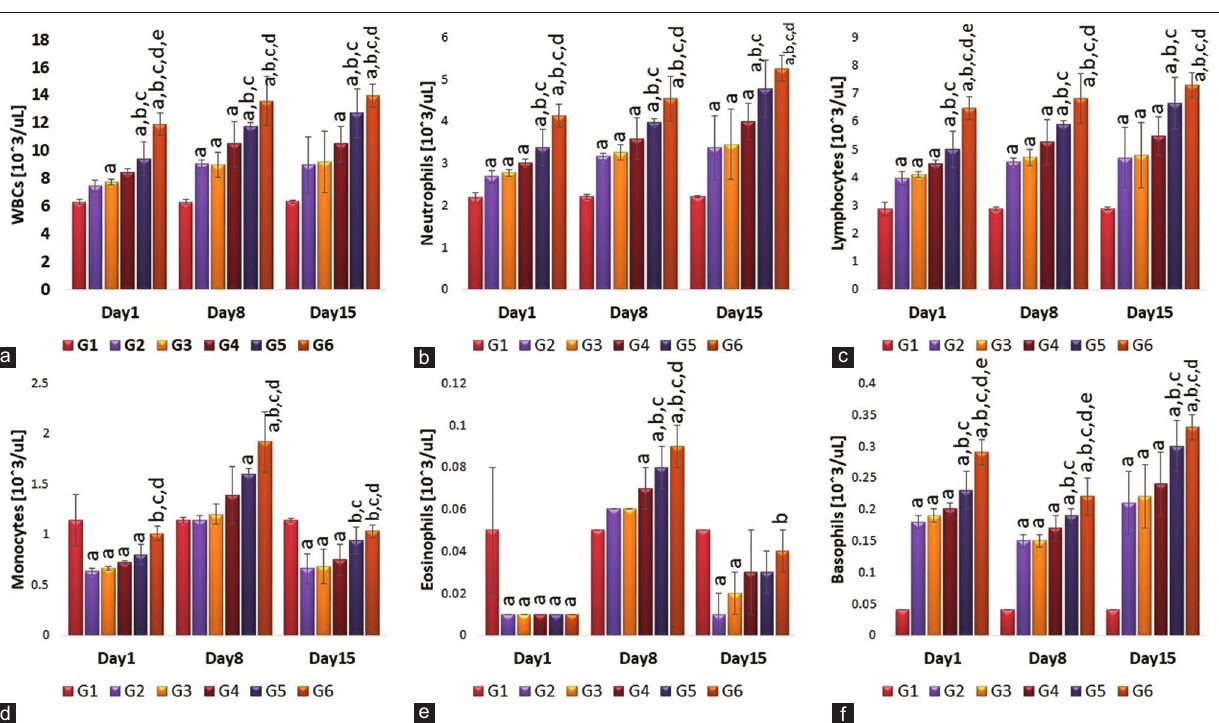
Figure-2: (a-f) Effect of single and repeated intravenous injection of 300 μ g/kg body weight 50 nm either gold nanosphere or gold nanorods in male rabbits on total white blood cells (WBCs), differential WBCs on days 1, 8, and 15 post-treatment. Means carrying superscripts are significantly different at p<0.05 based on Tukey’s honestly significant difference. a=Significantly different versus G1, b=Significantly different versus G2, c=Significantly different versus G3, d=Significantly different versus G4, and e=Significantly different versus